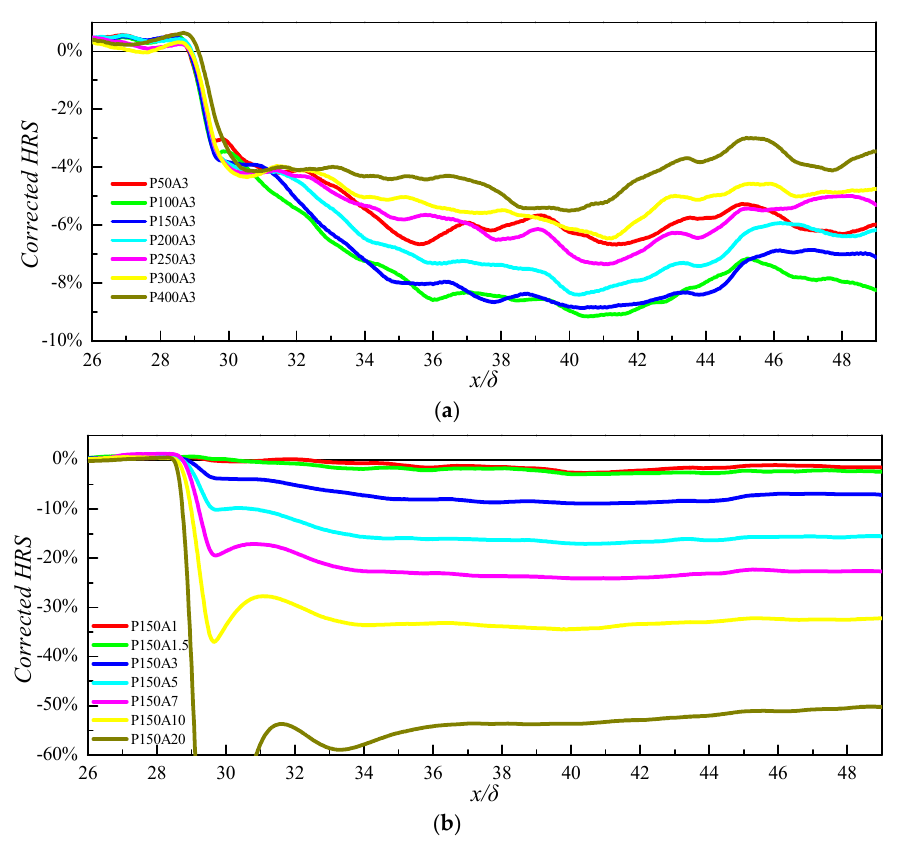
Figure 8. Corrected HR for Group 1 ( a ) and Group 2 ( b ).